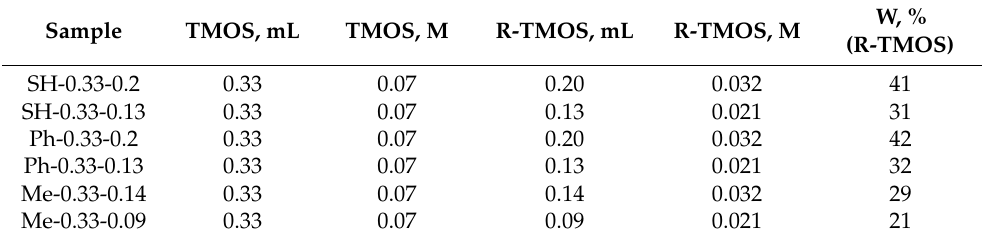
Table 4. Conditions for the synthesis of SiO 2 –R, where R: –SH, –CH 3 ,